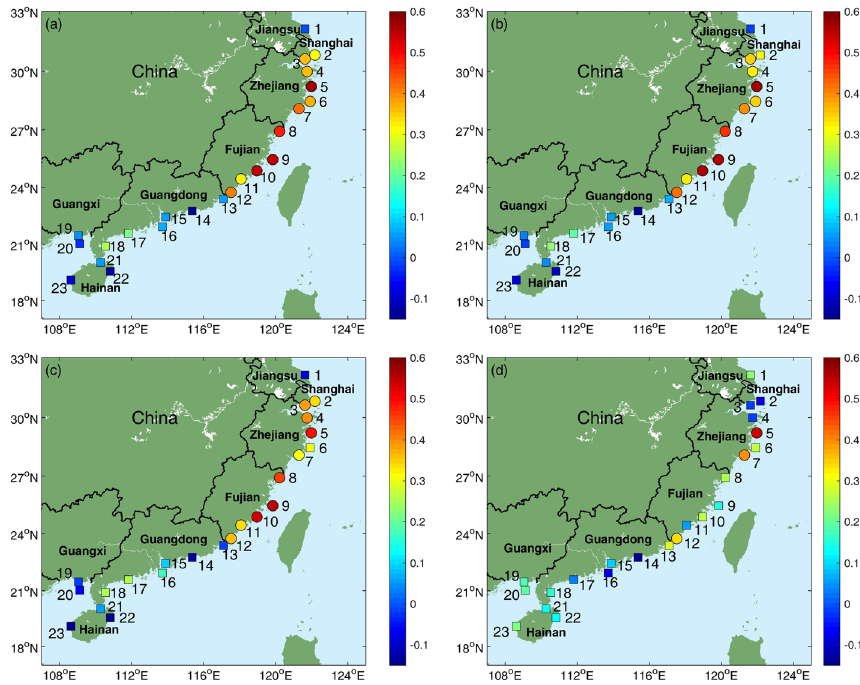
Figure 3. Correlation coefficients between the annual maximum storm surges (AMTSSs) and ( a ) Niño-3.4 index, ( b ) ONI index, ( c ) Niño 3 index and ( d ) EMI index at different tide-gauge stations. Circles and squares represent correlations significant and insignificant at 90% confidence level, respectively. Figures were plotted using MATLAB R2018b (http:// www. mathw orks.